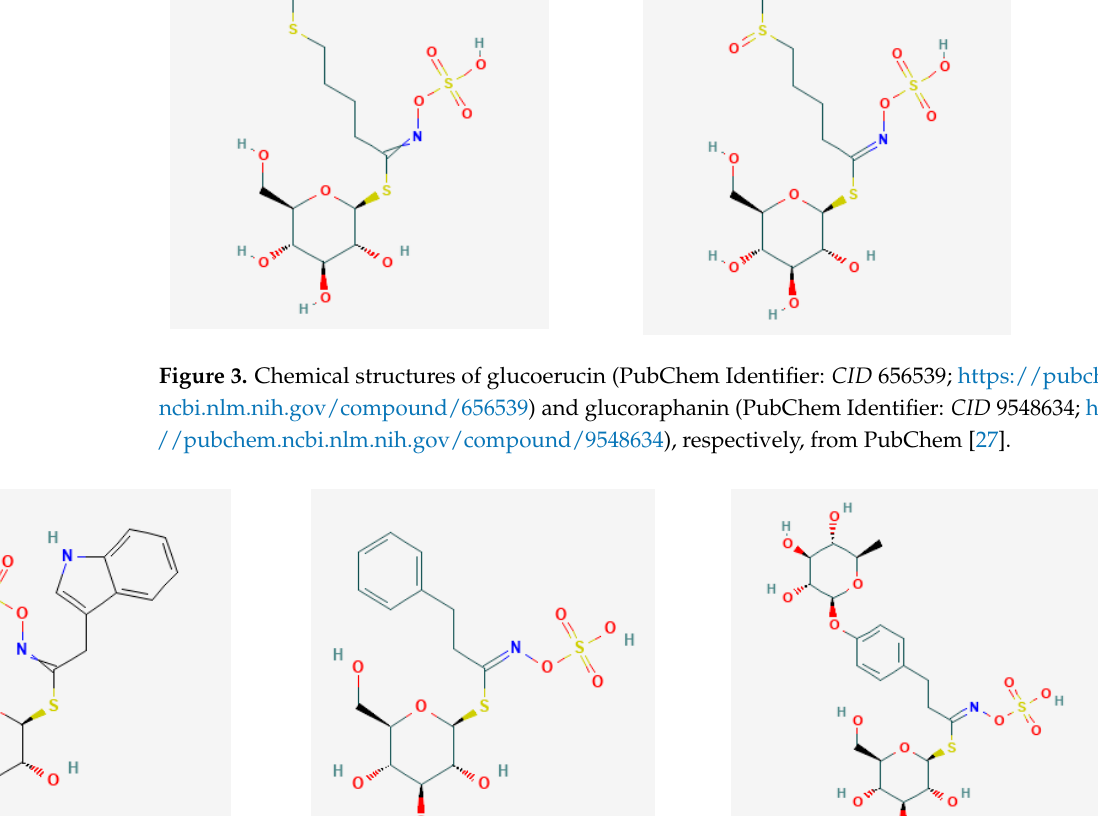
Figure 4. Chemical structures of glucobrassicin (PubChem Identifier: CID 656506; https://pubchem.ncbi.nlm.nih.gov/compound/656506), gluconasturtiin (PubChem Identifier: CID 5464032; https://pubchem.ncbi.nlm.nih.gov/compound/5464032), and glucomoringin (PubChem Identifier: CID 102222710; https://pubchem.ncbi.nlm.nih.gov/compound/102222710), respectively, from PubChem